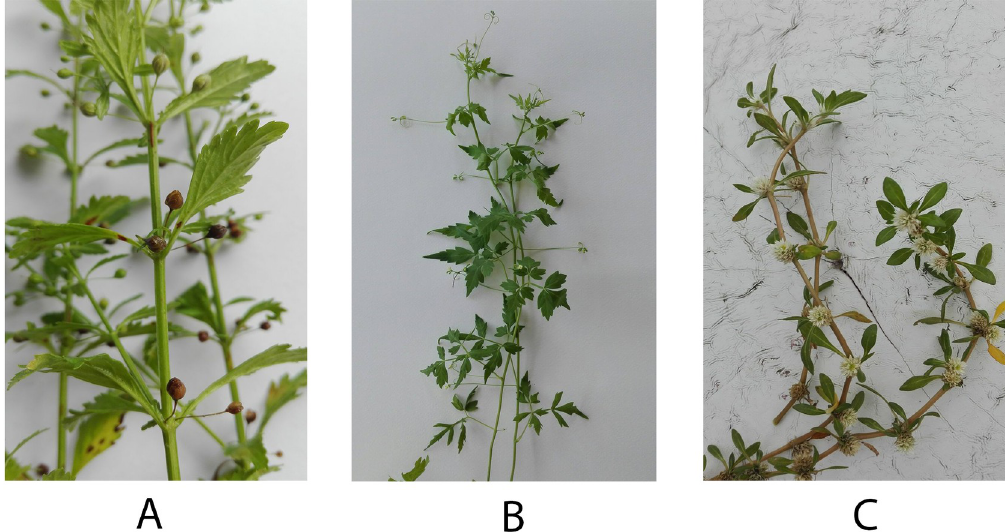
Fig 1. Selected Thai herbs used in the current study. (A) S . dulcis ; (B) C . halicacabum ; (C) G . celosioides .